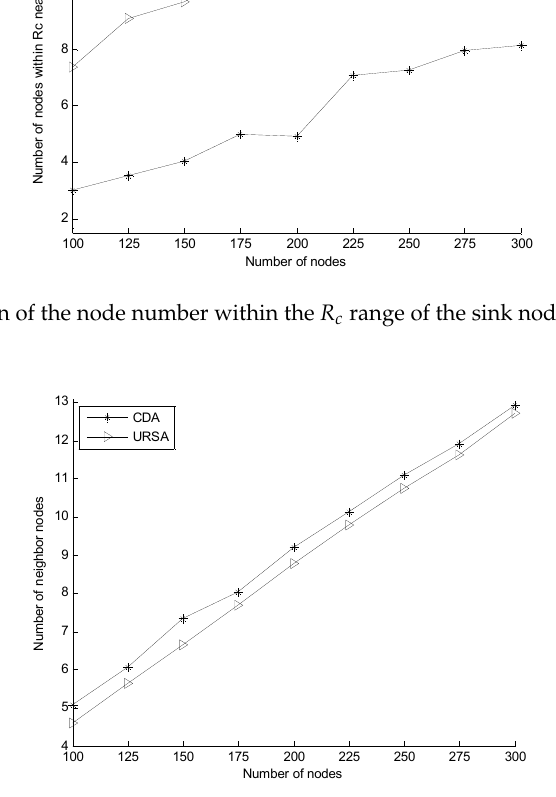
Figure 14. Comparison of the average number of neighbor nodes for a varying number of nodes.